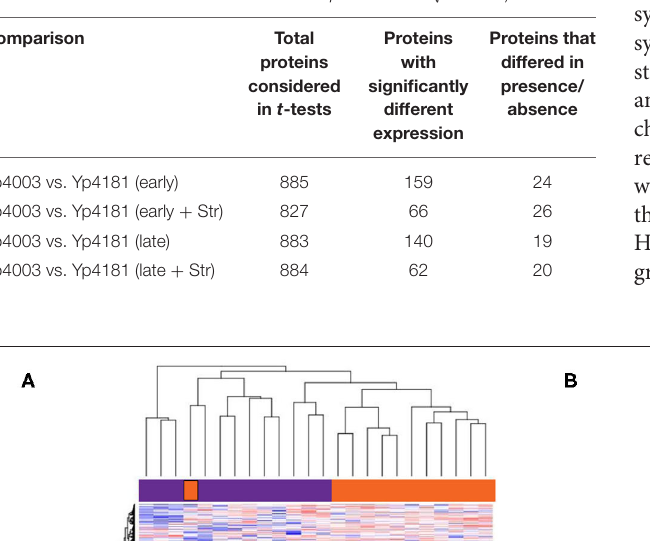
TABLE 4 | Number of proteins differentially expressed or found to differ in presence/absence between AMR and AMS Y. pestis strains ( p < 0.01). Comparison Total